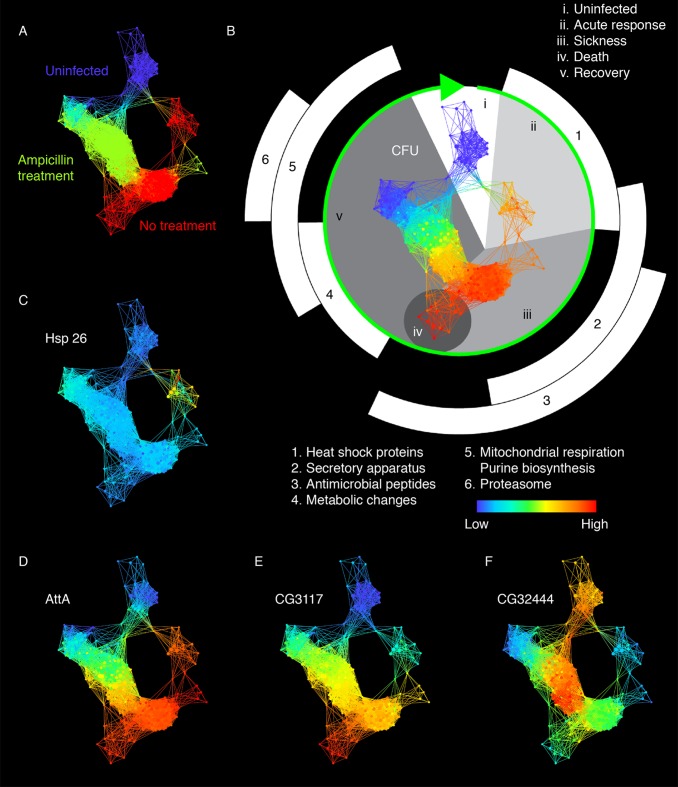
Disease space analysis of infected and recovering flies.(A) Infection map colored by treatment groups. The network was built using Ayasdi Core (data from S1 Table). Samples with similar expression patterns are binned together. Nodes are bins of individual samples. Bins containing the same sample are connected by edges. Cyan is the overlap of uninfected and no treatment groups, and orange is the overlap of ampicillin treatment and no treatment groups. (B) Infection map colored by CFU. The green arrow marks disease progression. Pathways of upregulated genes are numbered. Phases of infection are indicated by Roman numerals. (C) Infection map colored by heat shock protein 26. (D) Infection map colored by Attacin A. (E) Infection map colored by CG3117 (peptidase and death gene). (F) Infection map colored by CG32444 (aldose-1 epimerase and recovery gene).